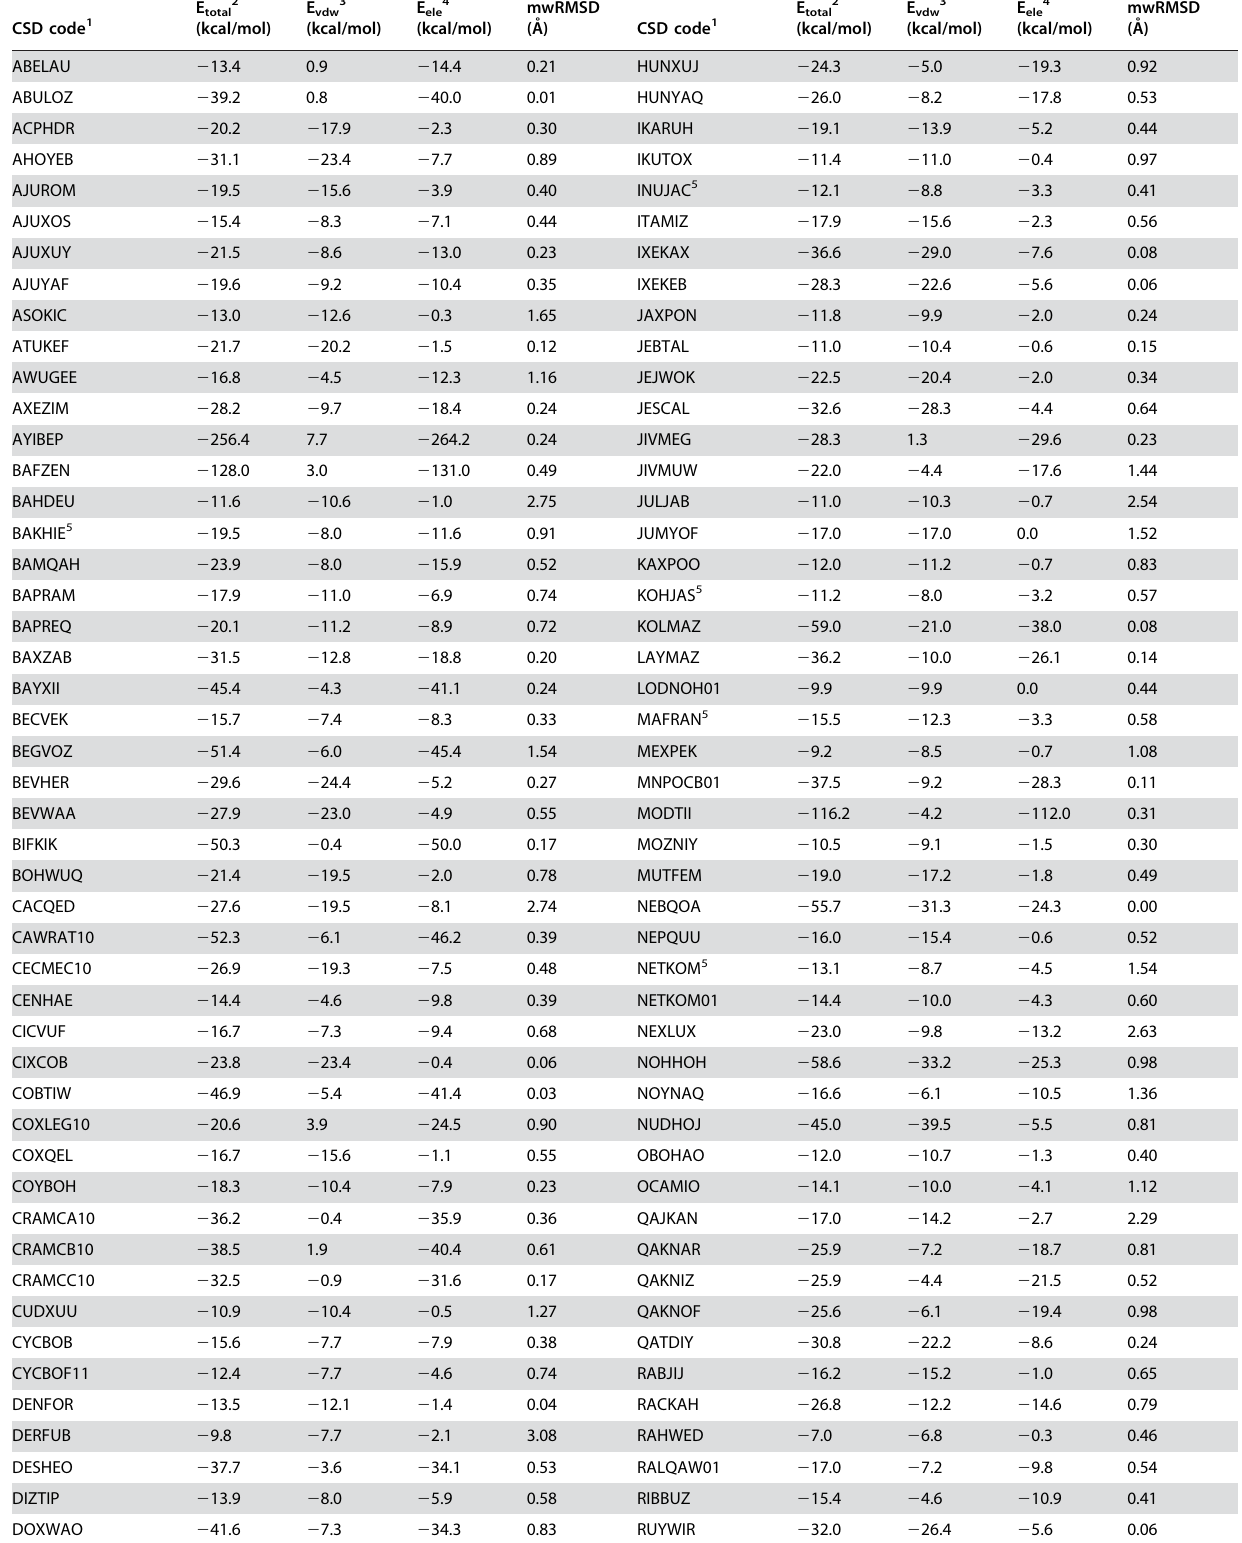
Table 1. The intermolecular interaction energies of the 161 small-molecule complexes generated by the EUDOC program and their mass-weighted root mean square deviations (mwRMSDs) relative to their corresponding crystal structures. .. ... .... ... ... .... ... ... .... ... ... .... ... ... .... ... ... .... ... ... .... ... ... .... ... ... .... ... ... .... ... ... .... ... ... .... ... ... .... ... ... .... ... ... . CSD code